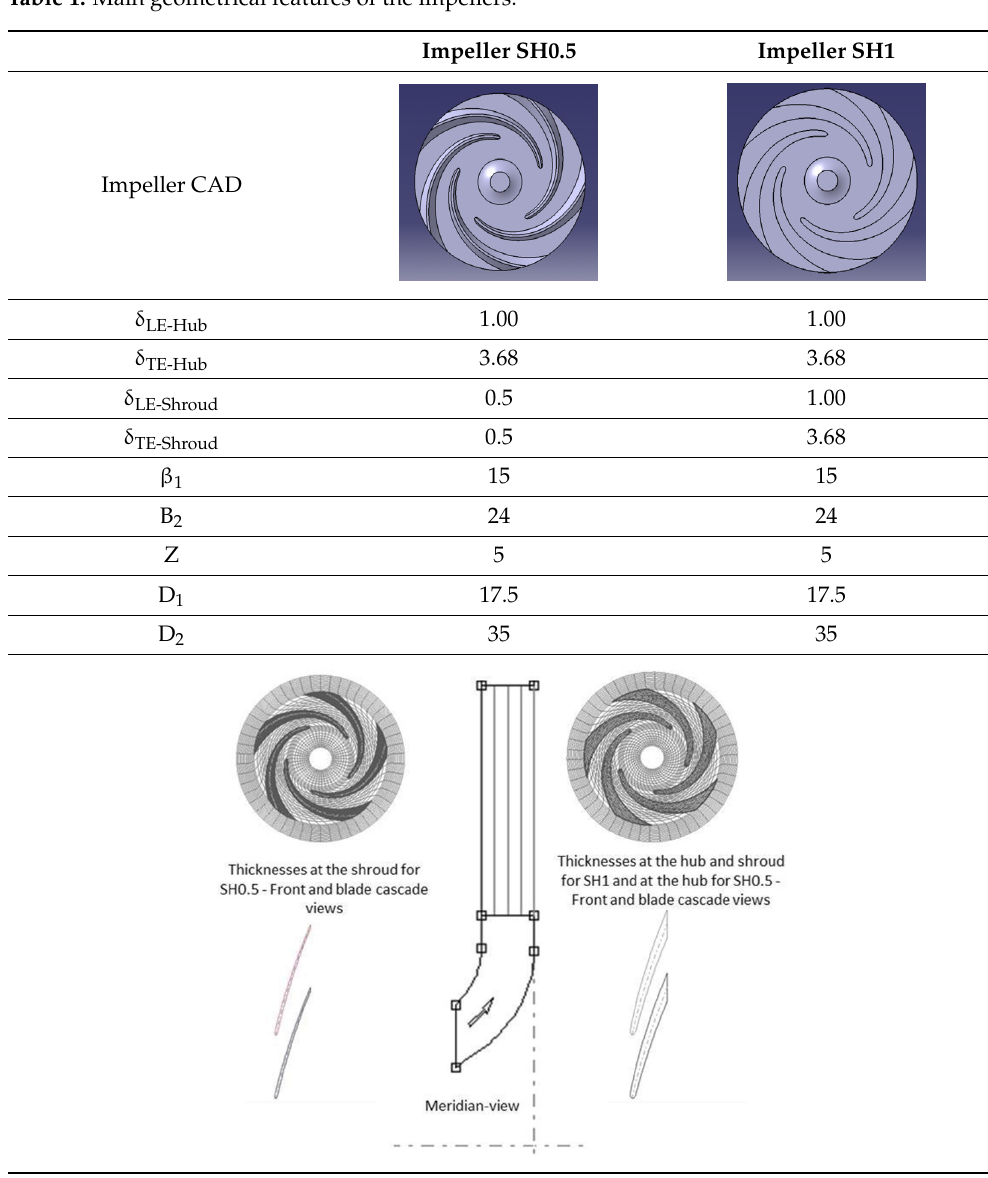
Table 1. Main geometrical features of the impellers.